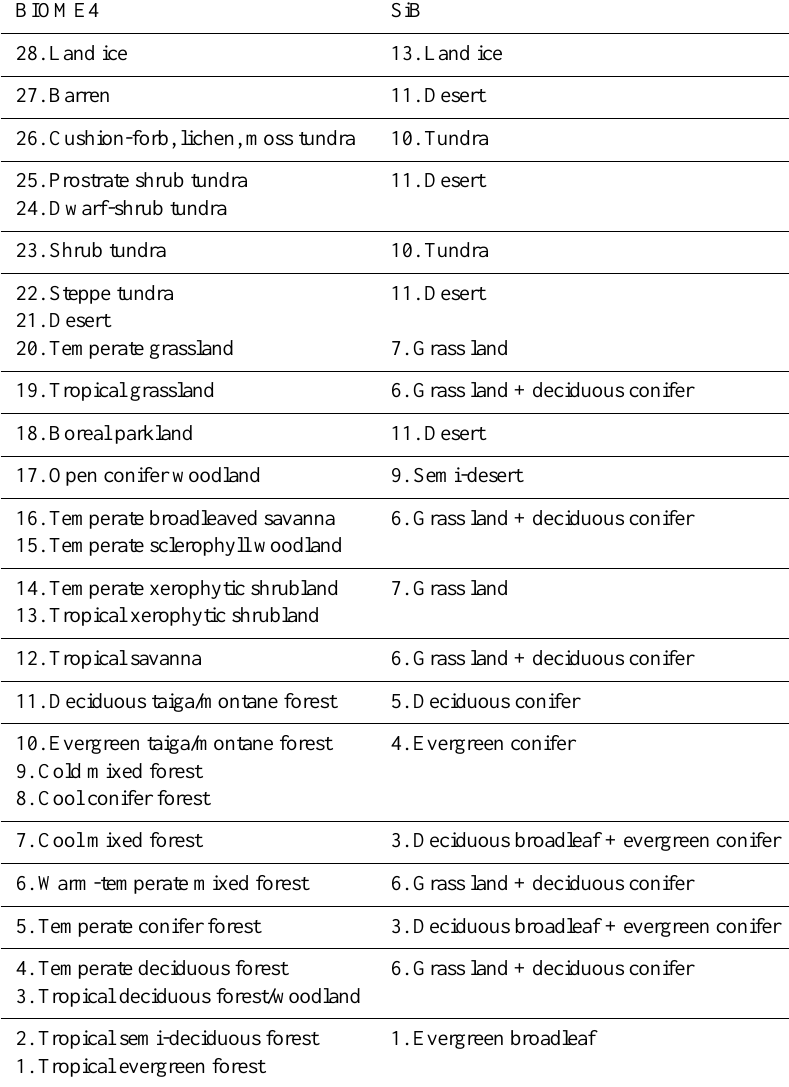
Table 3. Converting scheme of BIOME4 vegetation types to SiB classification used in this study. BIOME4